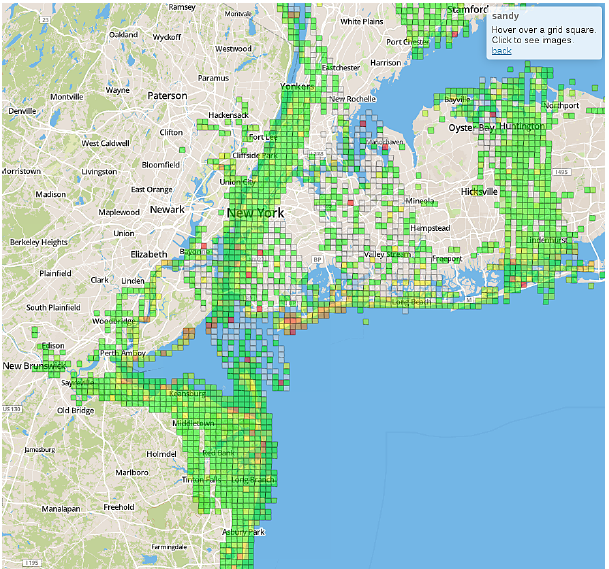
Fig. 1. Crowdsourced assessments for the Civil Air Patrol data. Damage assessment: red = high, yellow = medium, green = none.